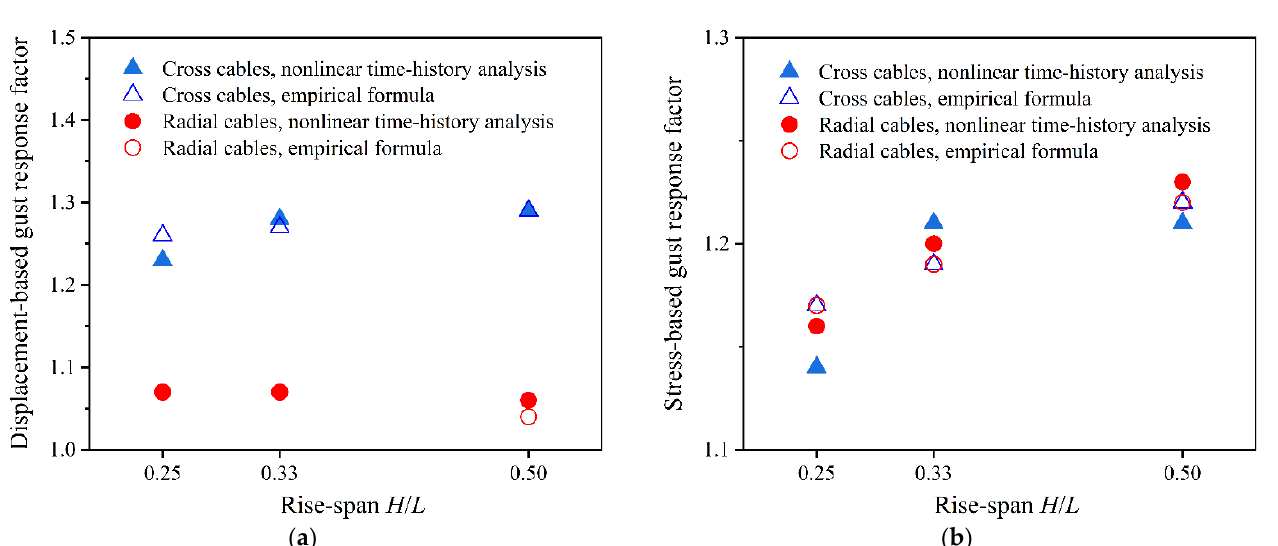
Table 6. Recommendations of gust response factors and nonlinear adjustment factors.